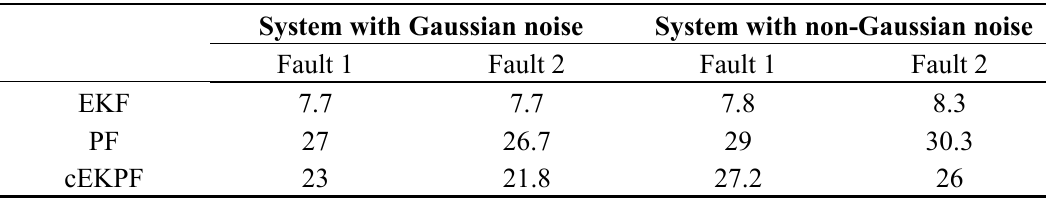
Table 7. Computational effort of the EKF, the PF, and the cEKPF.